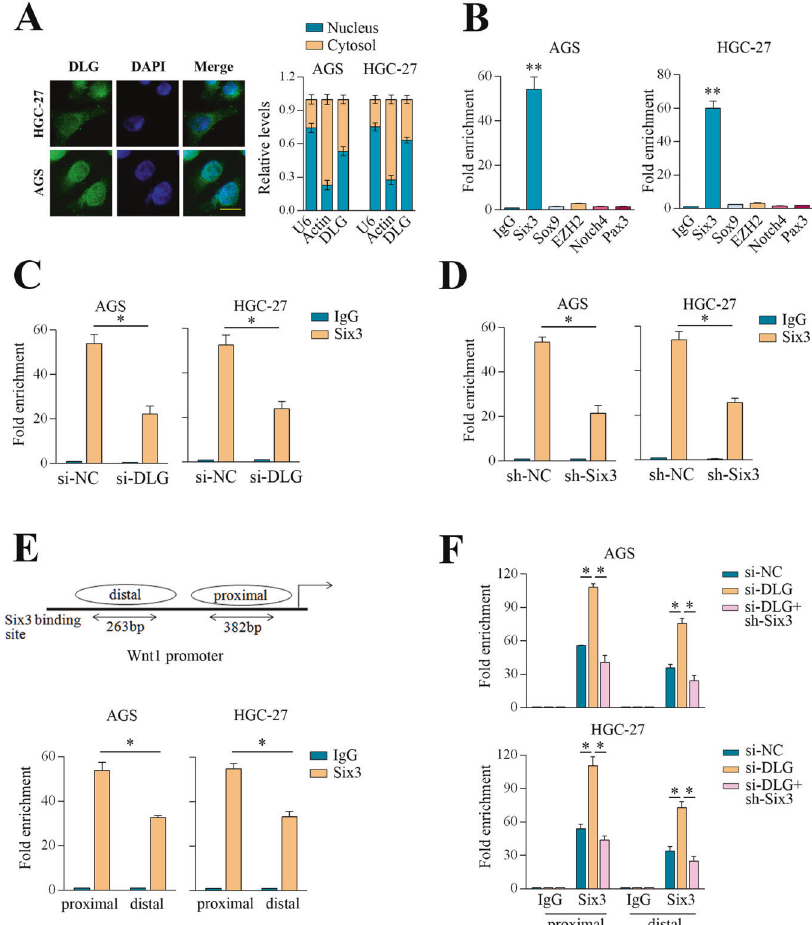
Fig. 4 DLGAP1-AS2 binding to Six3 relieved its occupancy in Wnt1 promoter regions. A FISH and fractionation assays for the subcellular location of DLGAP1-AS2 in AGS and HGC-27 cells. B RIP assays for the potential interaction between DLGAP1-AS2 and several transcriptional regulators that targeted Wnt1. C , D RIP assays for the binding between DLGAP1-AS2 and Six3 upon DLGAP1-AS2 or Six3 knockdown in GC cells. E Schematic representation of Six3 binding sites in Wnt1 promoter (upper). ChIP-qPCR assays showing occupancy of Six3 in both Wnt1 promoter regions (proximal and distal) in GC cells (lower). F ChIP-qPCR assays showing differential recruitment of Six3 to both Wnt1 promoter regions upon DLGAP1-AS2 knockdown or combined knockdown of DLGAP1-AS2 and Six3 in GC cells. The data shown are representative of three independent experiments. Scale bar: 10 μ m. * P < 0.05. ** P <